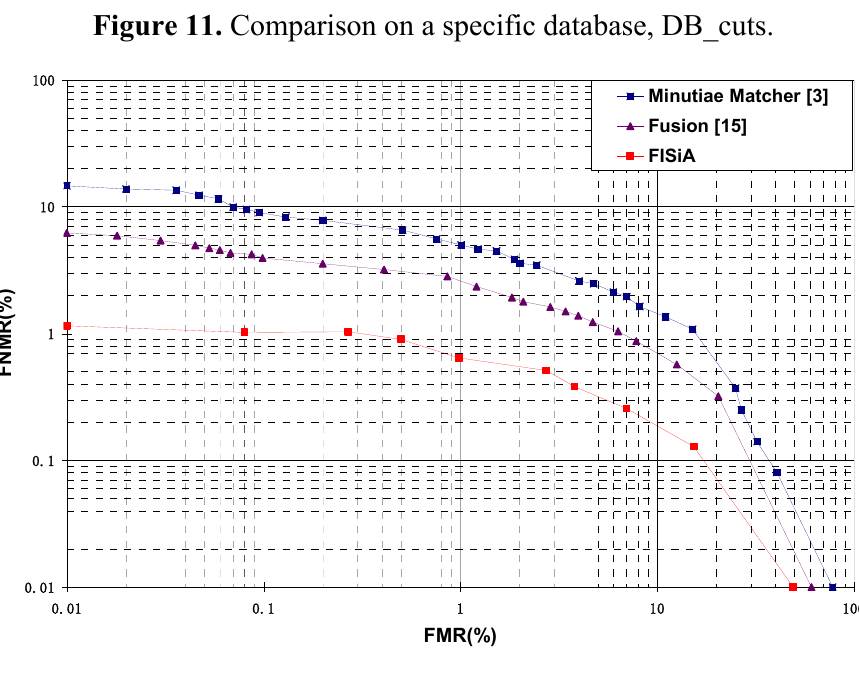
Figure 12. Example of genuine pairs in